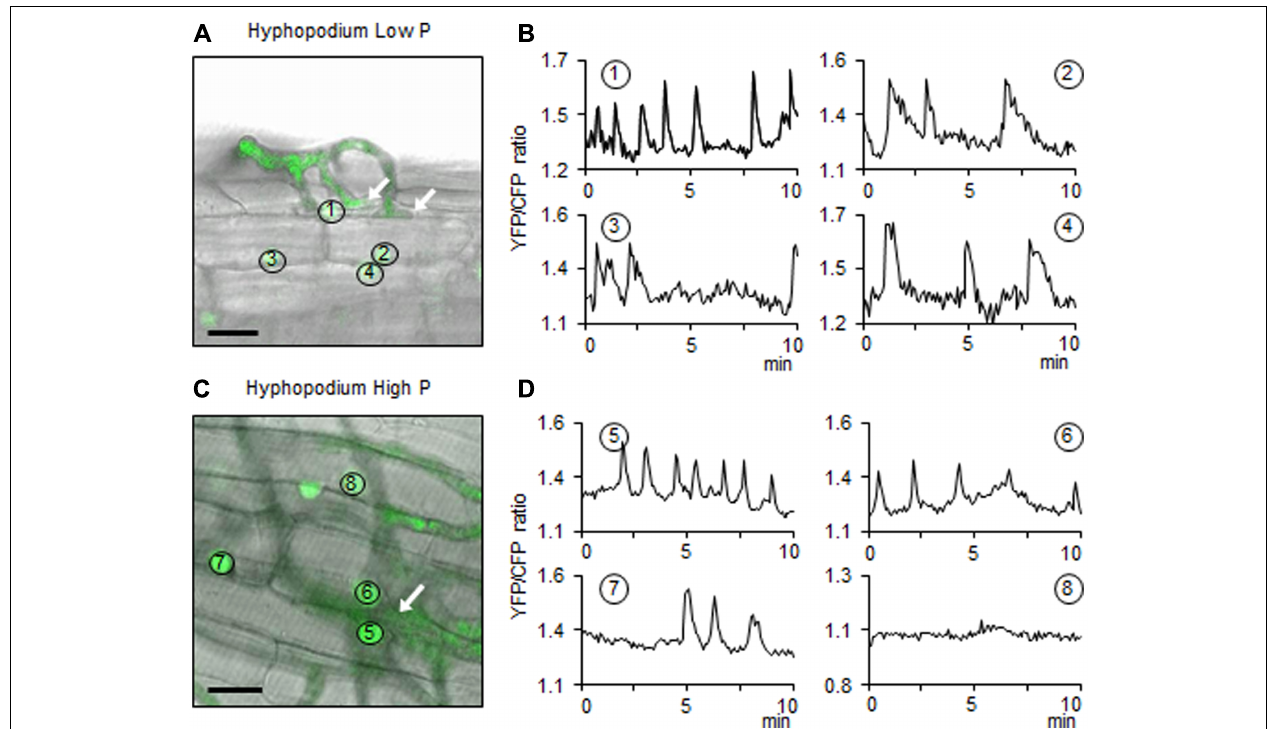
hyphopodium and epidermal cells. Panel (C) corresponds to a focal plane underneath the hyphopodium, in the root epidermis. Circles with numbers identify the nuclei in which calcium spiking was recorded. (B,D) The graphs represent oscillations of nuclear calcium concentration measured over 10 min in the nuclei shown in (A) and (C) , respectively. Vertical axis: arbitrary unit for YFP fluorescence/CFP fluorescence ratio, horizontal axis: time